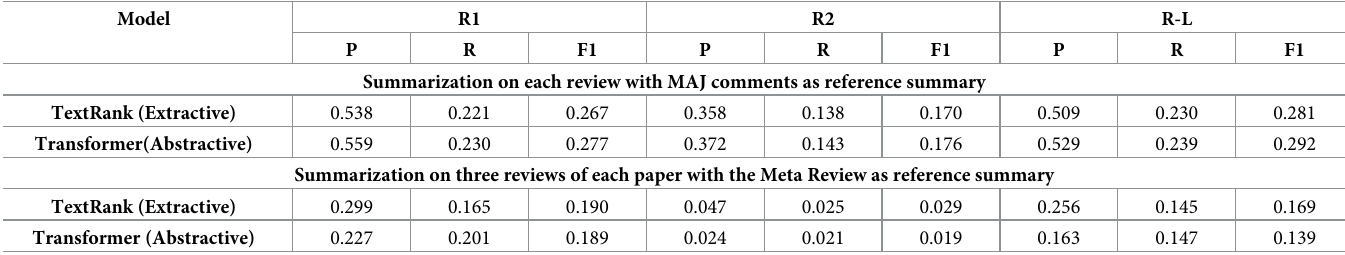
Table 9. P ! Precision, R ! Recall, R1 ! ROUGE with unigram, R2 ! ROUGE-2 for bigram overlap, R-L ! ROUGE-L for longest common subsequence. Model